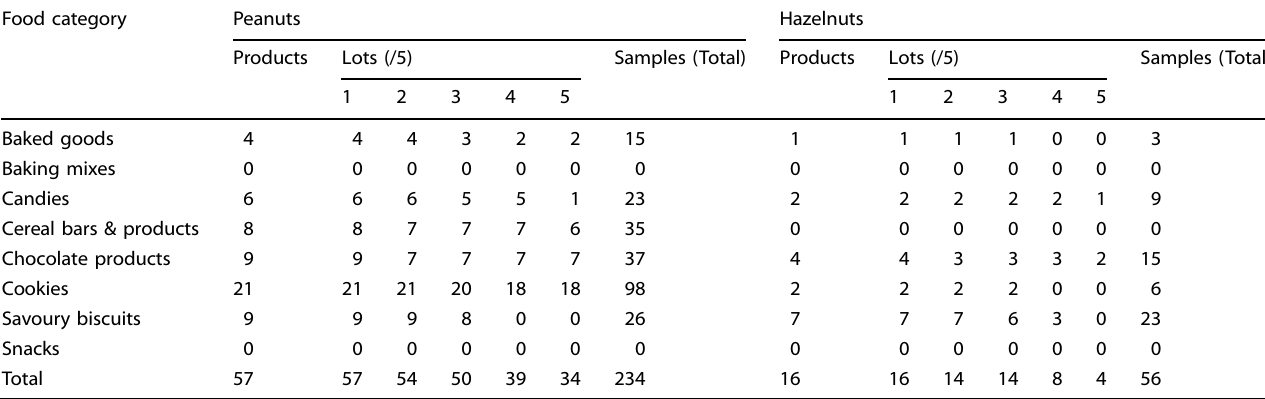
Table 2. Purchased products per allergen and food category with an allergen-free